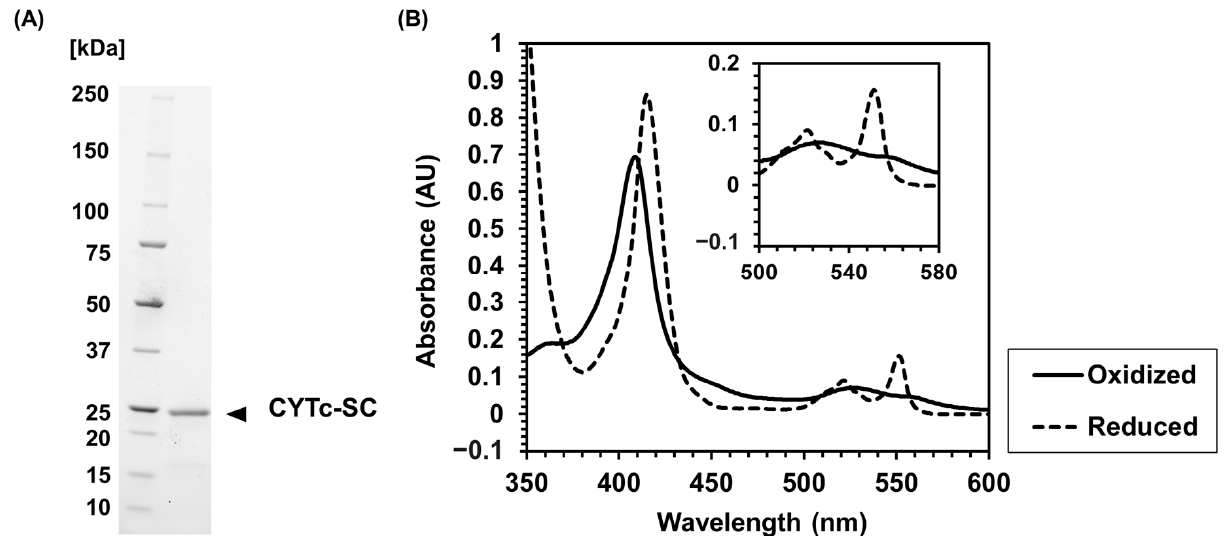
Figure 1. Characterization of recombinantly expressed CYTc-SpyCatcher (CYTc-SC). ( A ) SDS-PAGE analysis of the purified sample of CYTc-SC (expected molecular weight: 23 kDa). ( B ) Absorbance spectra in the range of 350–600 nm were recorded by a spectrometer. Solid and dashed lines indicate the spectrum of the purified sample of CYTc-SC in oxidative state treated with potassium ferricyanide and the spectrum of the purified sample of CYTc-SC in reduced state treated with sodium dithionite, respectively.